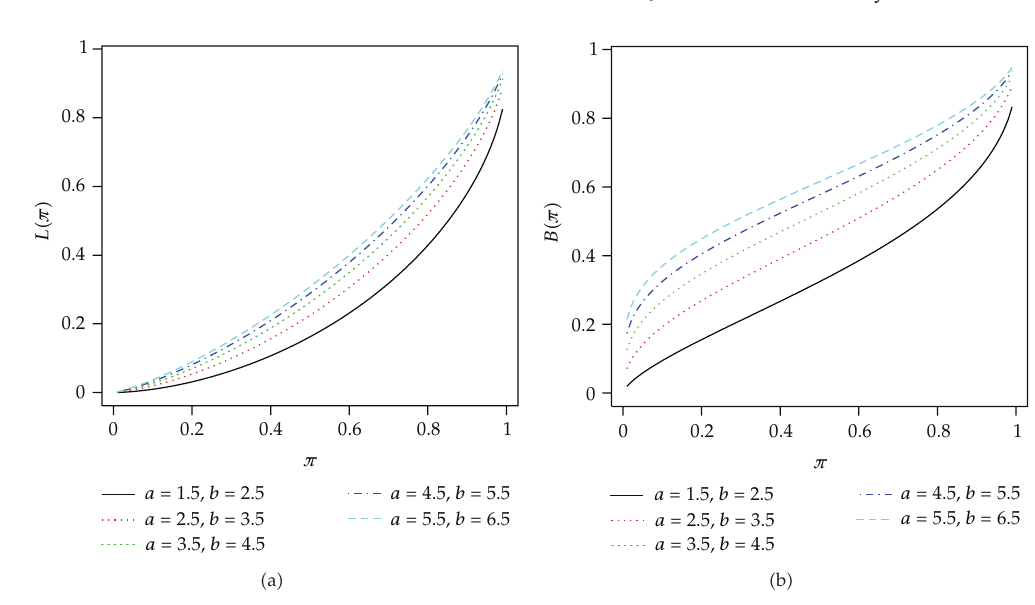
Figure 3: Plots of L (cid:2) π (cid:5) and B (cid:2) π (cid:5) with φ (cid:6) 1 and μ (cid:6)